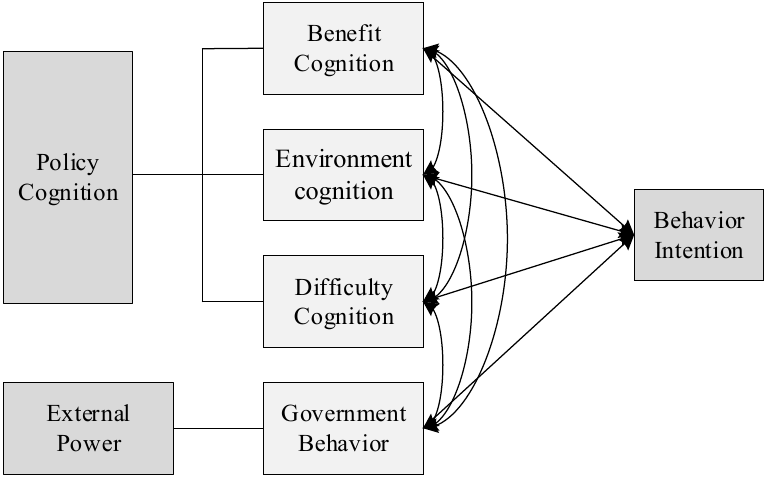
Figure 1. Theoretical framework of policy cognition affecting the withdrawal from